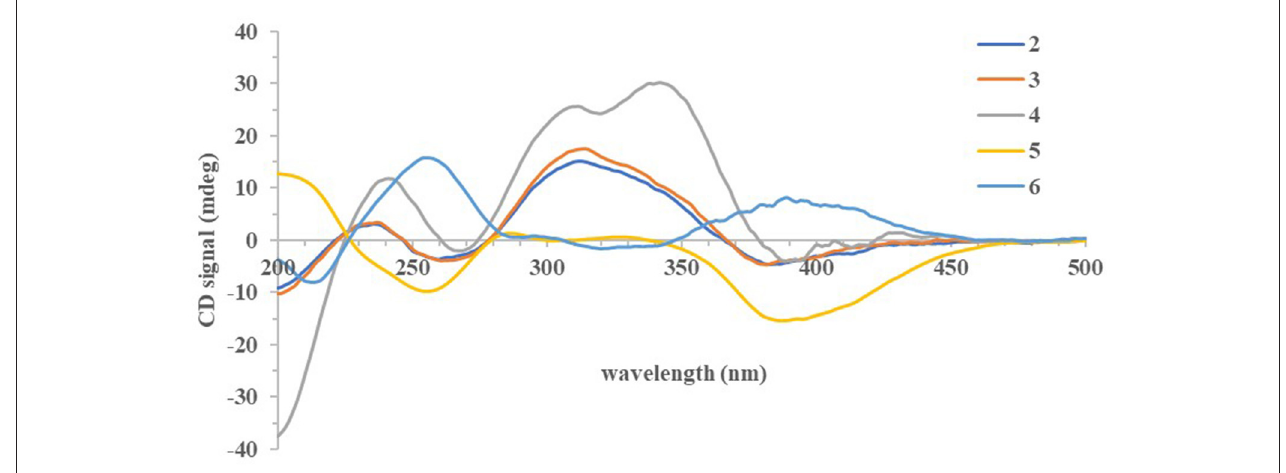
FIGURE 4 | Experimental ECD spectra of compounds